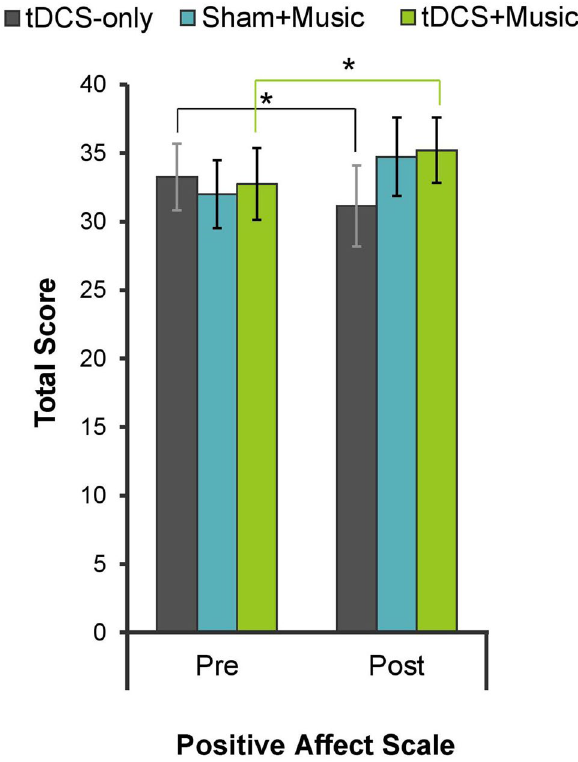
Figure 1. Change in PANAS ratings (post- minus pre-stimulation) by condition for positive and negative affect scales. Error bars represent standard error.